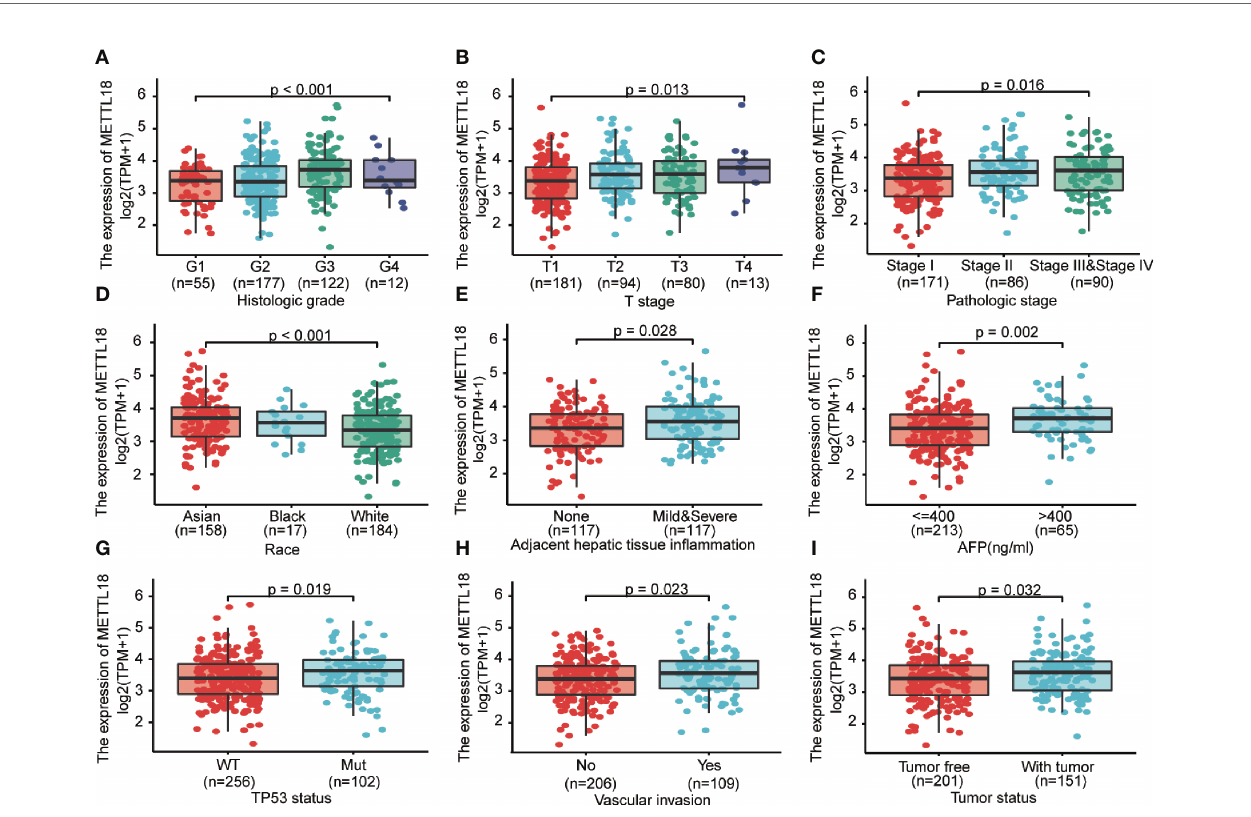
FIGURE 4 | Correlation between METTL18 expression and clinicopathological characteristics, including (A) histological grade, (B) T stage, (C) pathologic stage, (D) Race, (E) Adjacent hepatic tissue in fl ammation, (F) AFP, (G) TP53 status, (H) Vascular invasion, and (I) Tumor status in HCC patients in TCGA cohort. TCGA, The Cancer Genome Atlas; HCC, hepatocellular cancer.